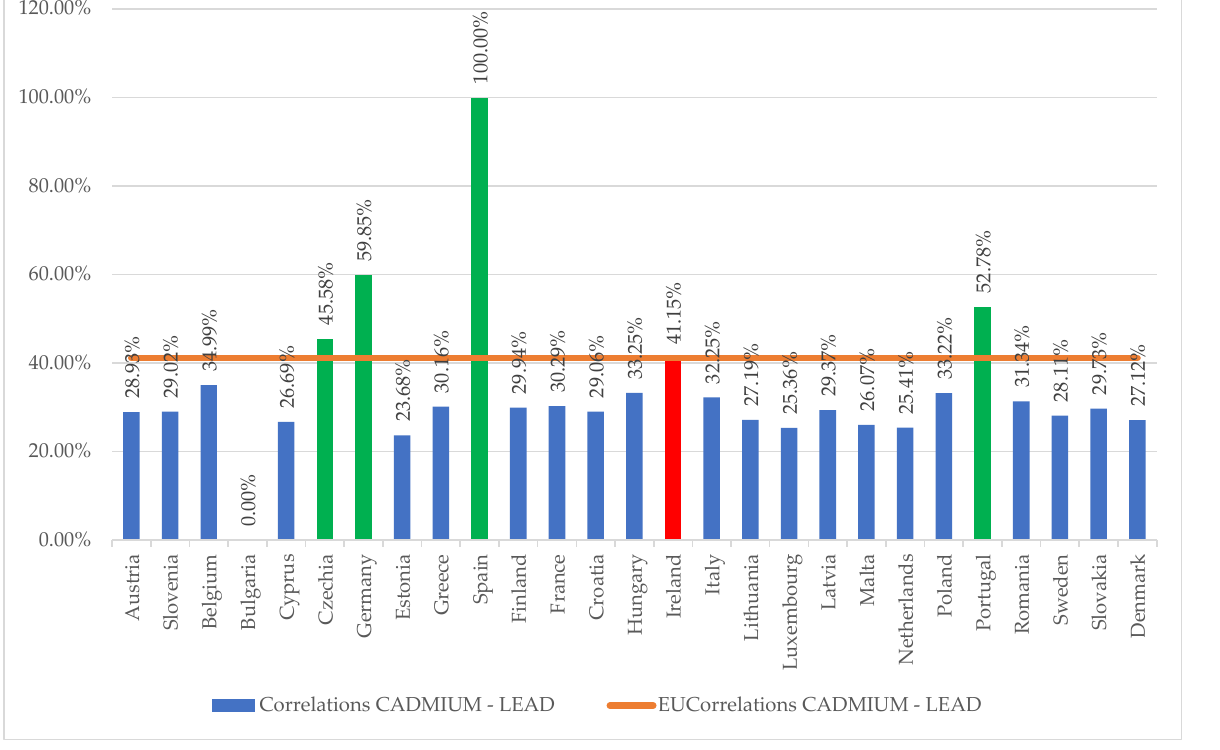
Figure 3. Evaluation of the degree of contribution of the particular model to the overall output of cadmium and lead water pollution control.